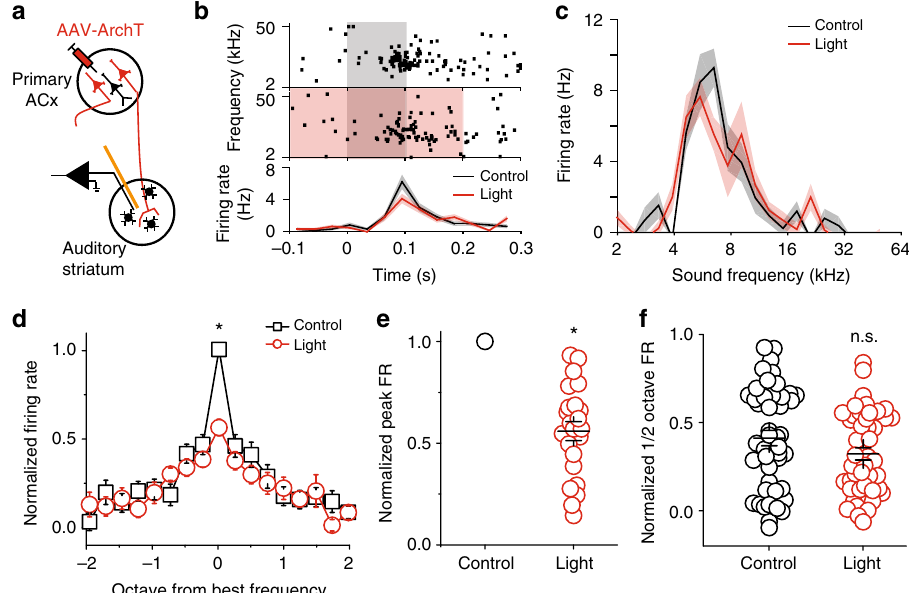
Fig. 4 Silencing the primary ACx projection to the auditory striatum reduced striatal MSN tonal responses to their best frequencies. a Illustration of recording setup for silencing primary ACx projection. b One example of recorded MSN single unit. Upper panels, raster plots of a MSN fi rings during tone presentation (gray shaded area) and tone + light presentation (red + gray shaded area). Tone: 0 – 0.1 s time window; Light: − 0.1 – 0.2 s time window. Lower panel, PSTH of the fi ring rates in response to tone alone (black) and tone + light (red). c Tuning plots of the example shown in ( b ). d Average tuning plots at the tone alone (black) and tone + light (red) conditions. Frequencies are aligned to the best frequency of each single unit and scaled in octave away from the best frequency. The best frequencies are determined separately from control and light-on trials for each single unit. Firing rates at different frequencies of each single unit are normalized to the fi ring rate at the best frequency from control trials. ( e ) Normalized individual and averaged fi ring rates at best frequencies at the tone alone (black) and tone + light (red) conditions. ( f ) Normalized individual and averaged fi ring rates at frequencies ± ½ octave away from the best frequency at the tone alone (black) and tone + light (red) conditions. For d – f , n = 22 neurons from fi ve mice, data are presented as mean values, error bars are s.e.m., * p < 0.01, t test in ( d ) and paired t test